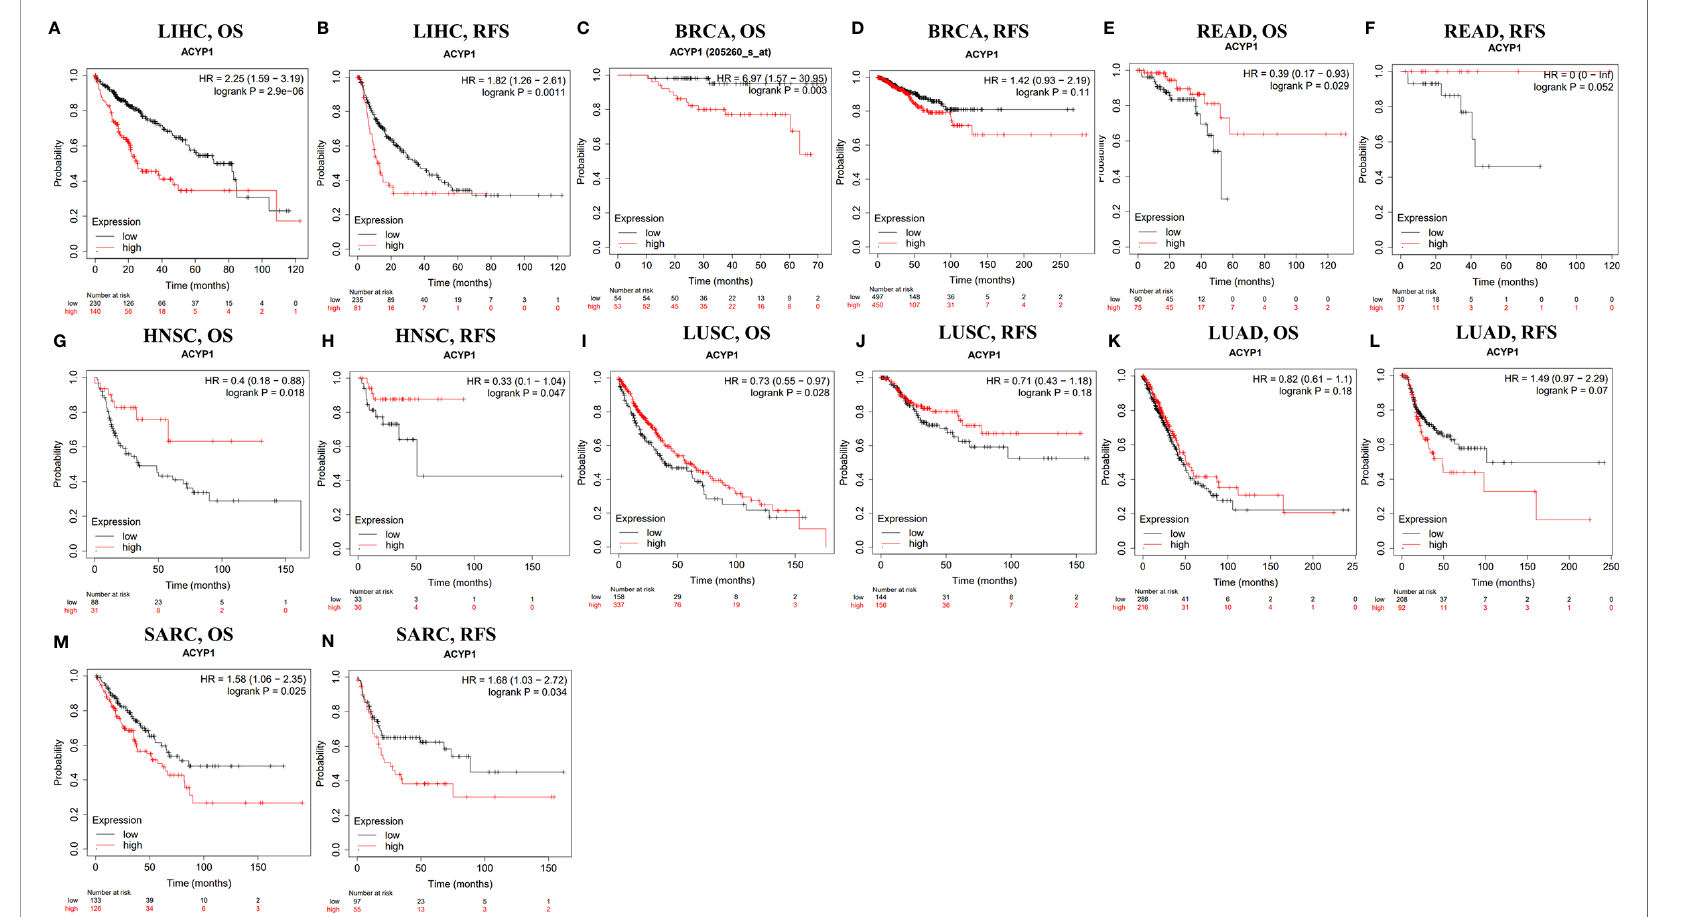
FIGURE 2 | The survival of patients with high and low expression of ACYP1 across cancers in the Kaplan – Meier Plotter database. OS and RFS of liver LIHC (A, B) , BRCA (C, D) , READ (E, F) , HNSC (G, H) , LUSC (I, J) , LUAD (K, L) , and SARC (M, N) patients. OS, overall survival; RFS, relapse-free